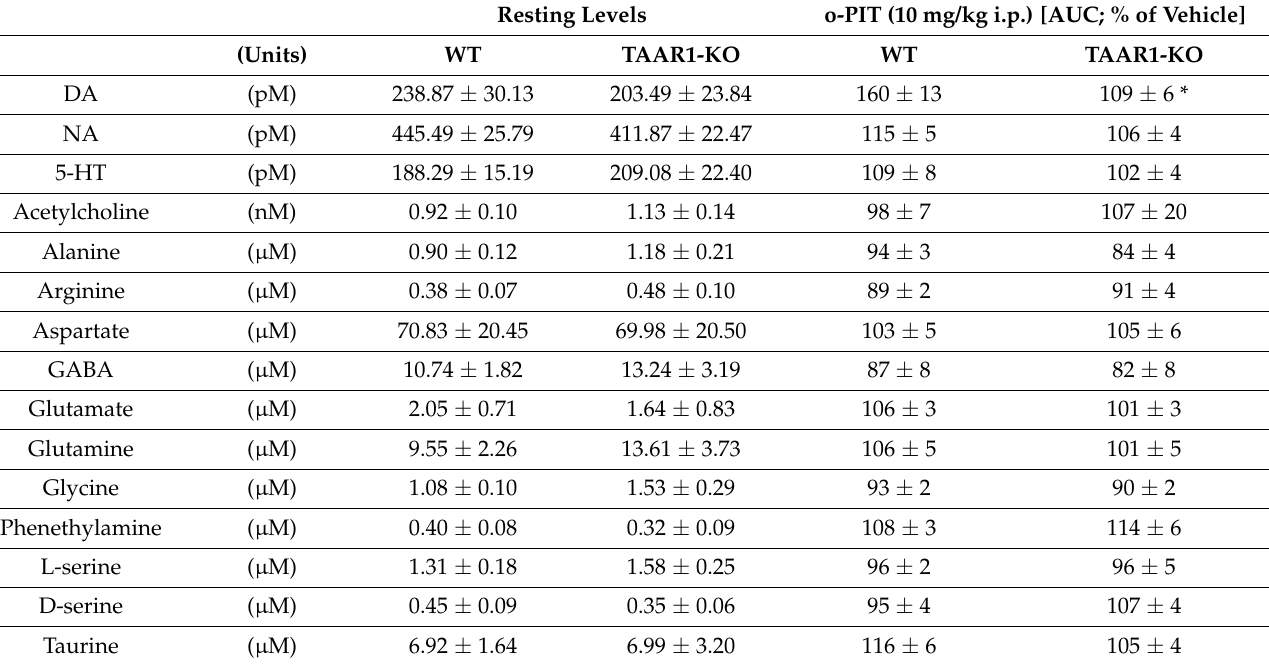
Table 1. Resting levels and o-PIT-induced changes in biogenic amines, acetylcholine and amino acids in dialysates of mPFC in freely moving mice. Values are mean ± SEM concentration not corrected for probe recovery. N ≥ 8 per groups. * p < 0.05 WT vs.